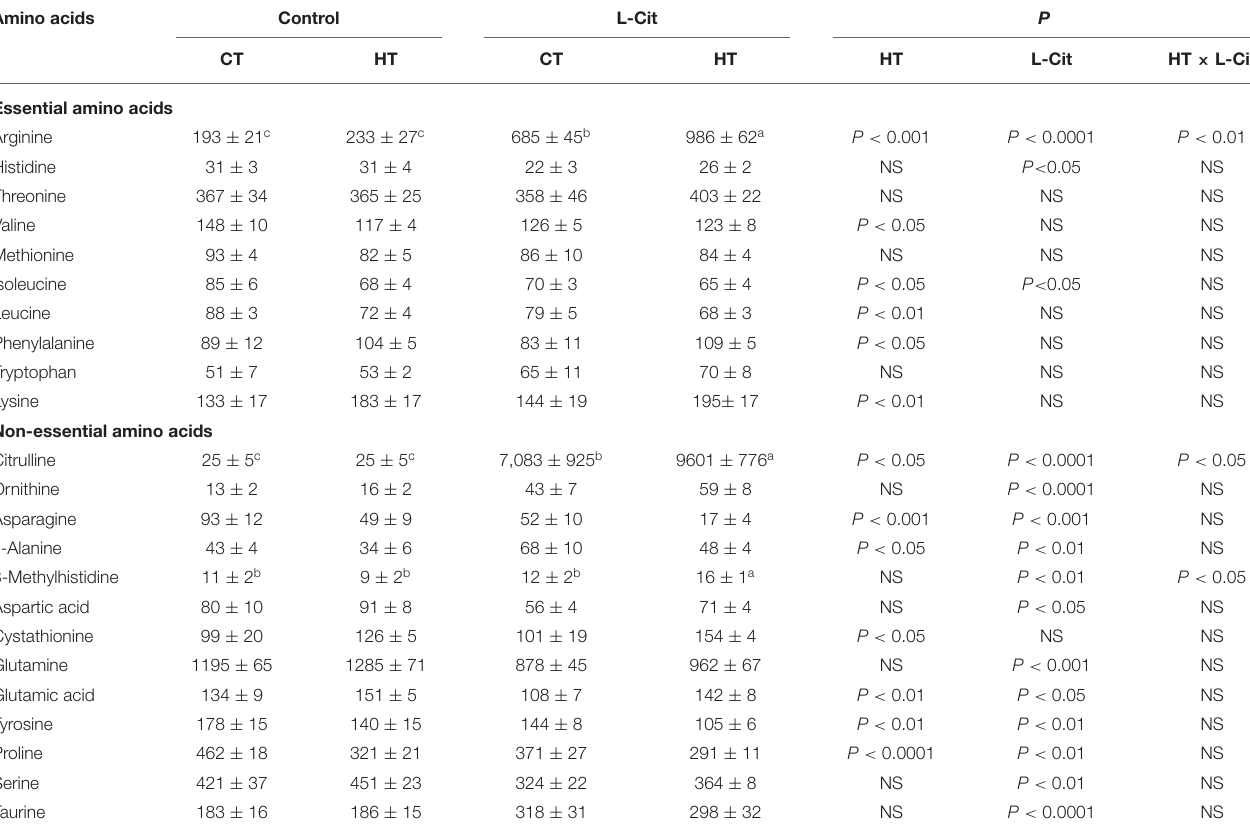
TABLE 2 | Effects of oral administration of L-Cit on free amino acid concentrations in the plasma of broilers. Amino acids